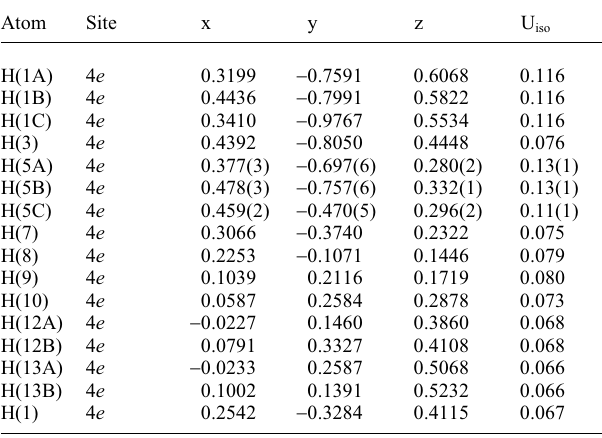
Table 2. Atomic coordinates and displacement parameters (in Å 2 )